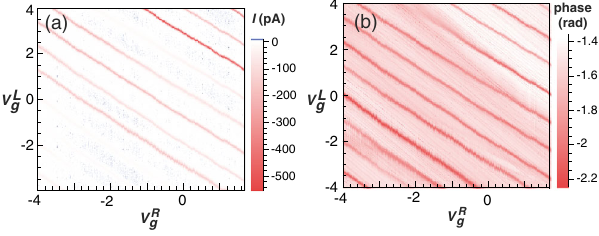
FIG. 6. Current I through the quantum dot (left panel) and cavity signal Δ φ (right panel) versus V L corresponding to the data of Figs. 3(c) and